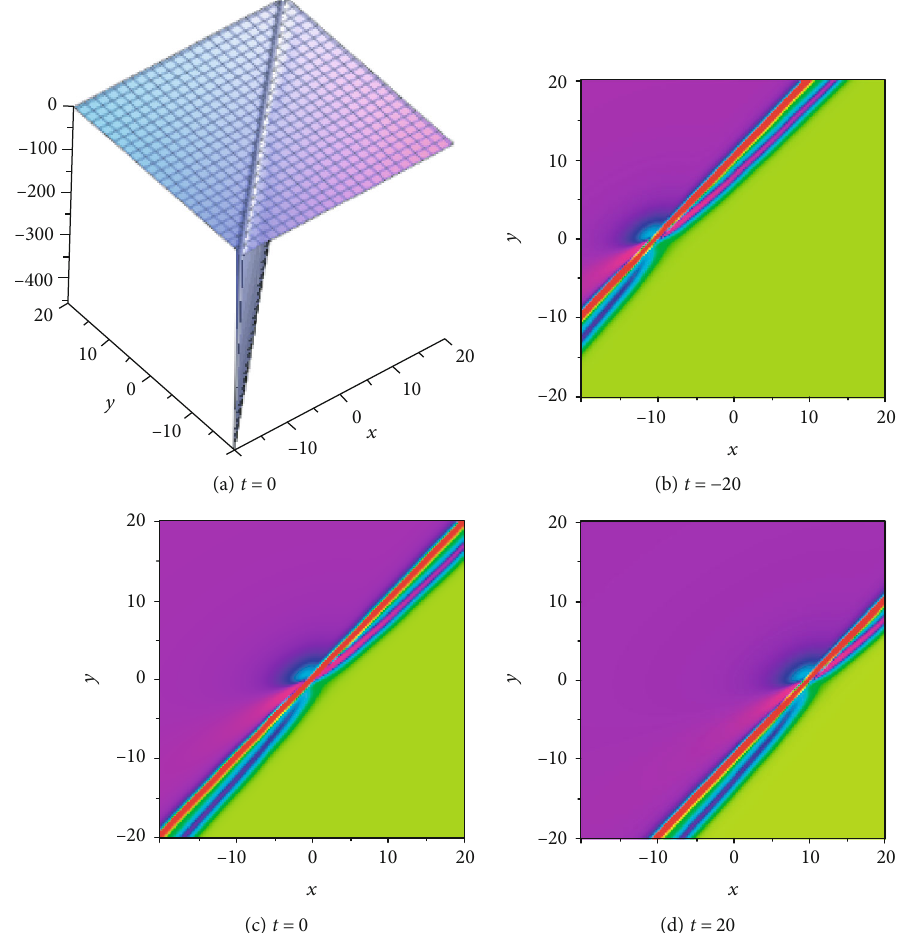
= 1 , a = 0 , a = 1 , a = 0 , a = 1 , beta = 1 , k 2 4 5 8 9